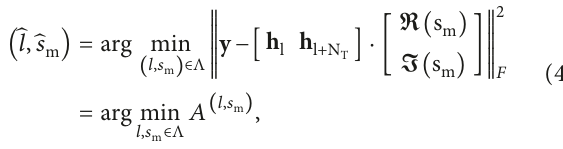
2 SM with 4QAM and ×